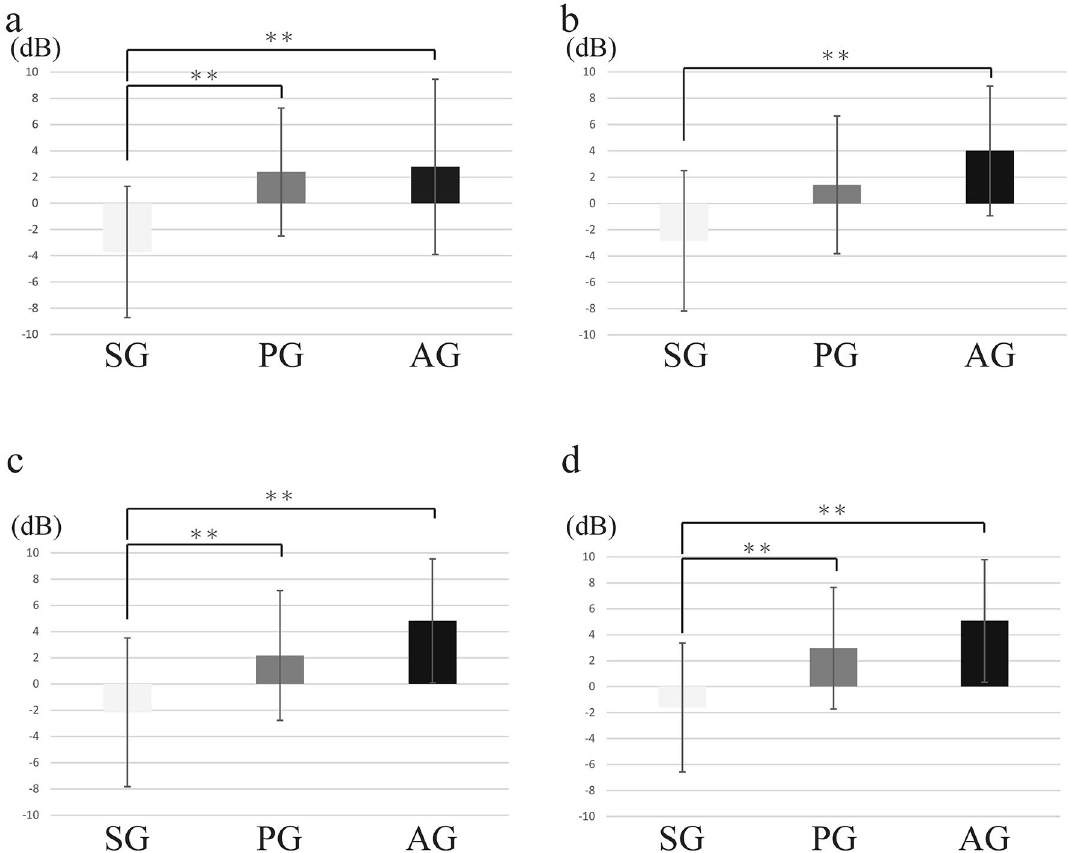
Figure 5. Result of ESBS. ( a ): At 256 points, the AD values of PG and AG were significantly higher than those of SG. ( b ): At 1024 points, AD values of AG were significantly higher than those of SG; however, there was no significant difference between SG and PG. ( c ): At 2048 points, the AD values of PG and AG were significantly higher than those of SG. ( d ): At 8192 points, the AD values of PG and AG were significantly higher than those of SG. (* = p < 0.05, ** = p <